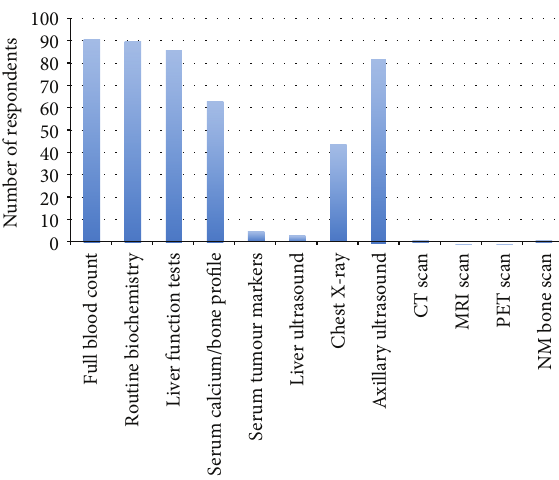
Figure 2: Investigations routinely performed for all patients with early breast